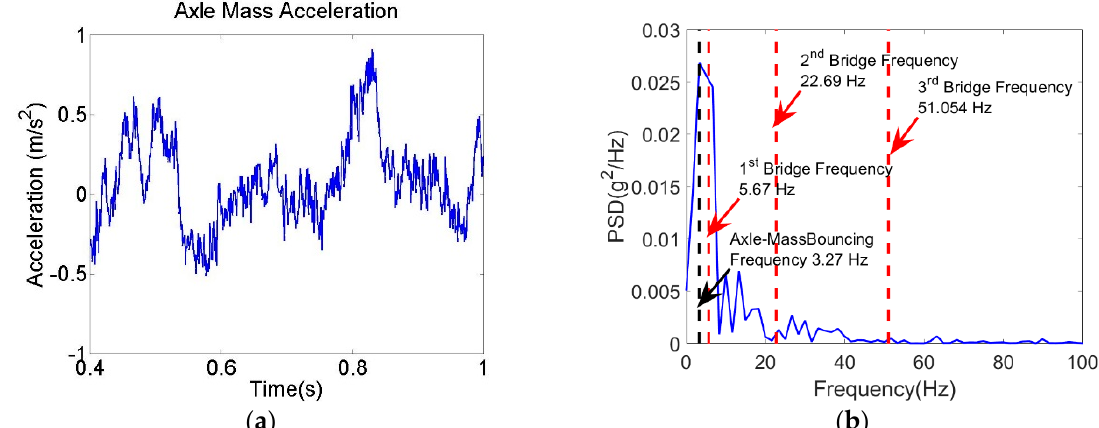
Figure 10. ( a ) Axle mass acceleration and ( b ) spectrum of the axle mass acceleration.